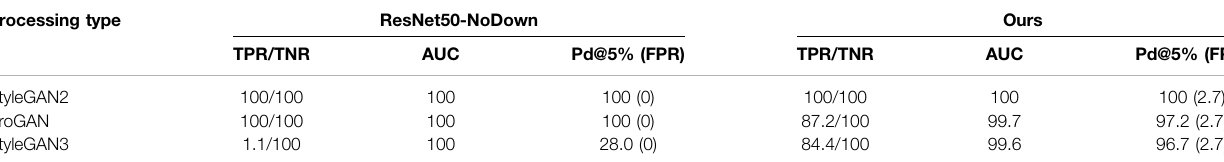
TABLE 2 | TPR/TNR (%), AUC (%) and Pd@5% (%) of the proposed method and the baseline on unprocessed images. Tests are carried out in matched (StyleGAN2) and mismatched (ProGAN and StyleGAN3) conditions.